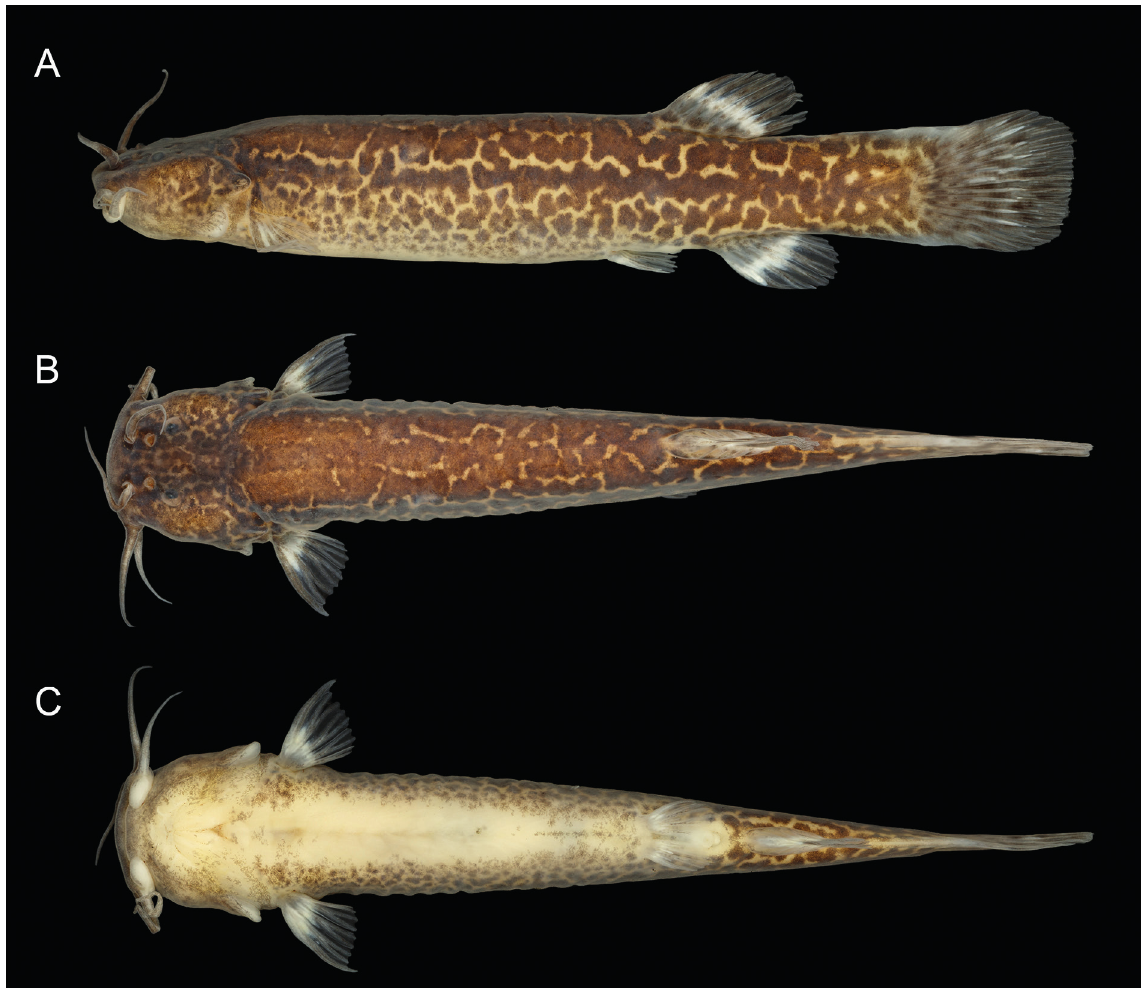
Fig. 1. Cambeva alphabelardense sp. nov., holotype (UFRJ 6990), 43.4 mm SL. A . Left lateral view. B . Dorsal view. C . Ventral